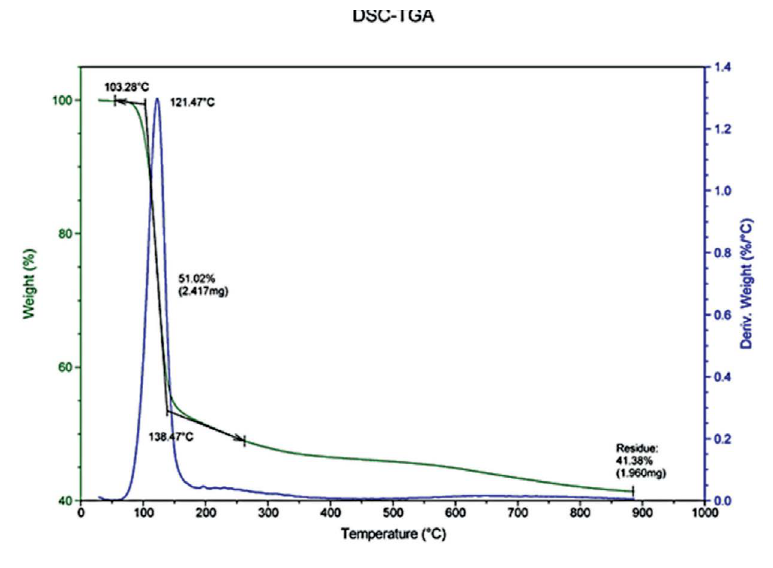
Fig. 2 Thermography of struvite crystals in the nitrogen atmosphere, showing a thermogravimetric peak at